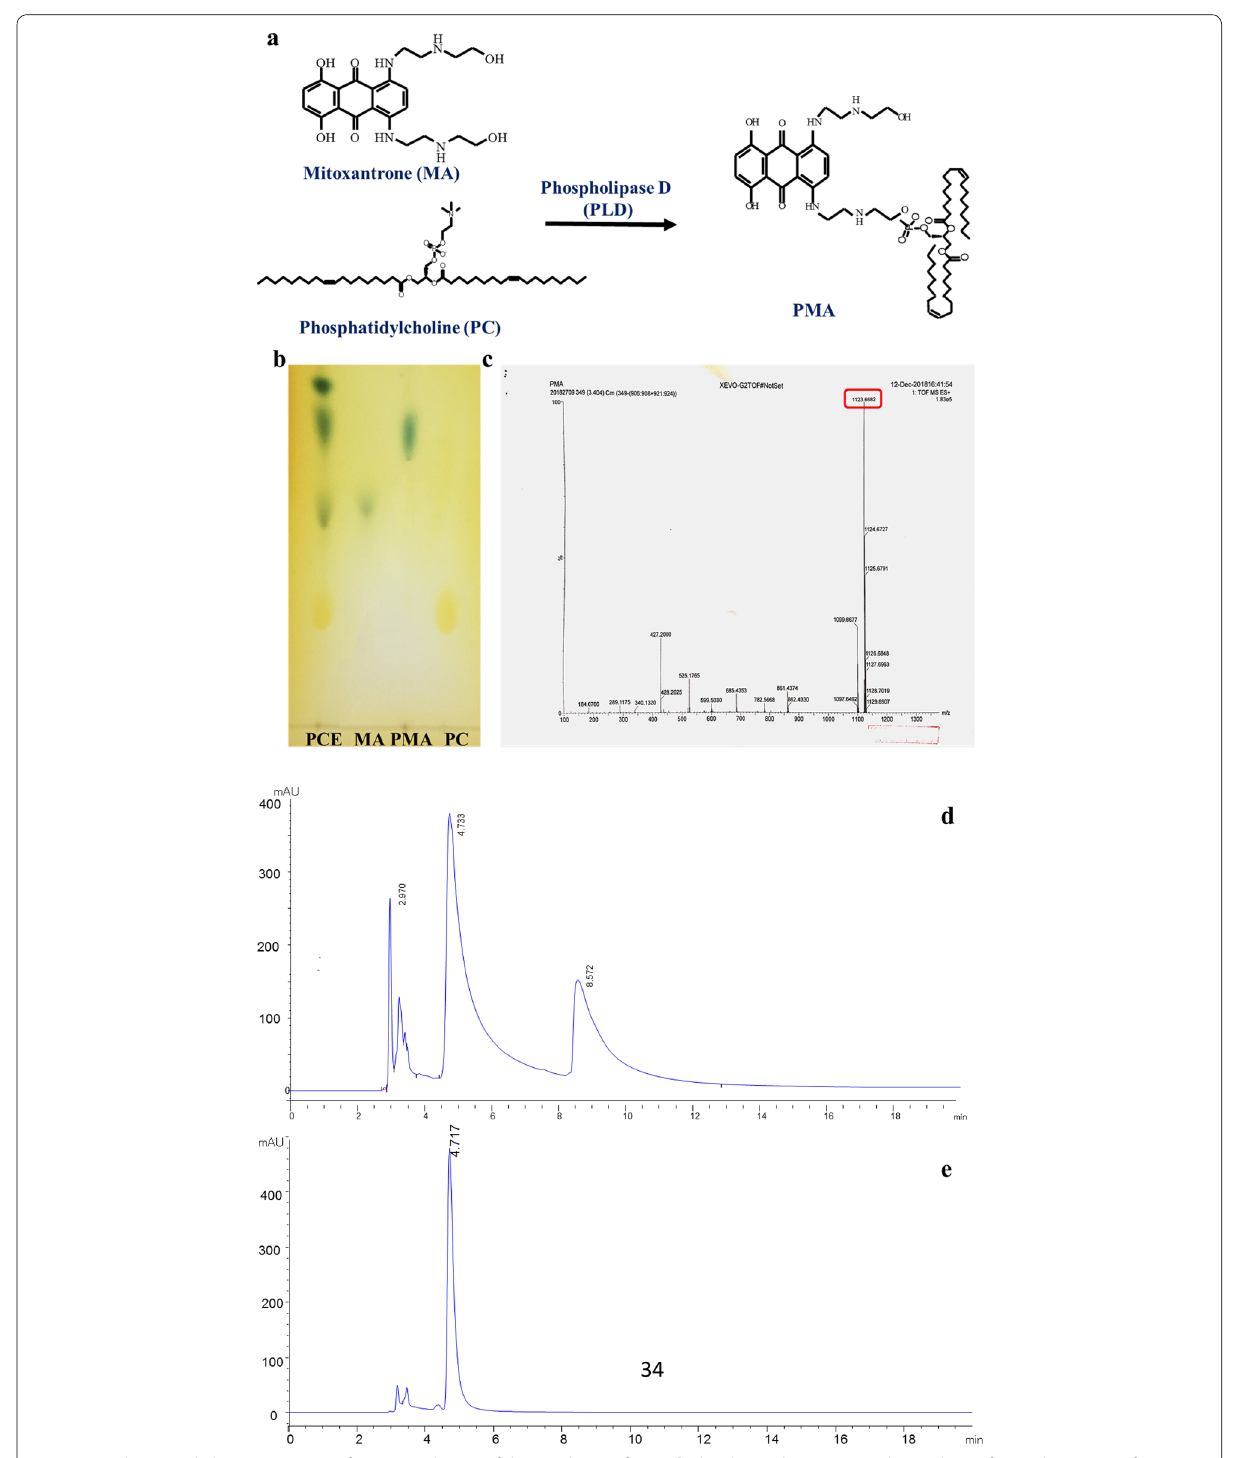
Fig. 1 Synthesis and characterization of PMA. a Scheme of the synthesis of PMA; b thin‑layer chromatography analysis of a crude extract of PMA (PCE), mitoxantrone (MA), (phosphatidyl mitoxantrone) PMA, and phosphatidylcholine; (PC); c MS analysis: electron spray ionization analysis of PMA; d HPLC chromatograms of crude extract of PMA (PCE); e HPLC chromatograms of